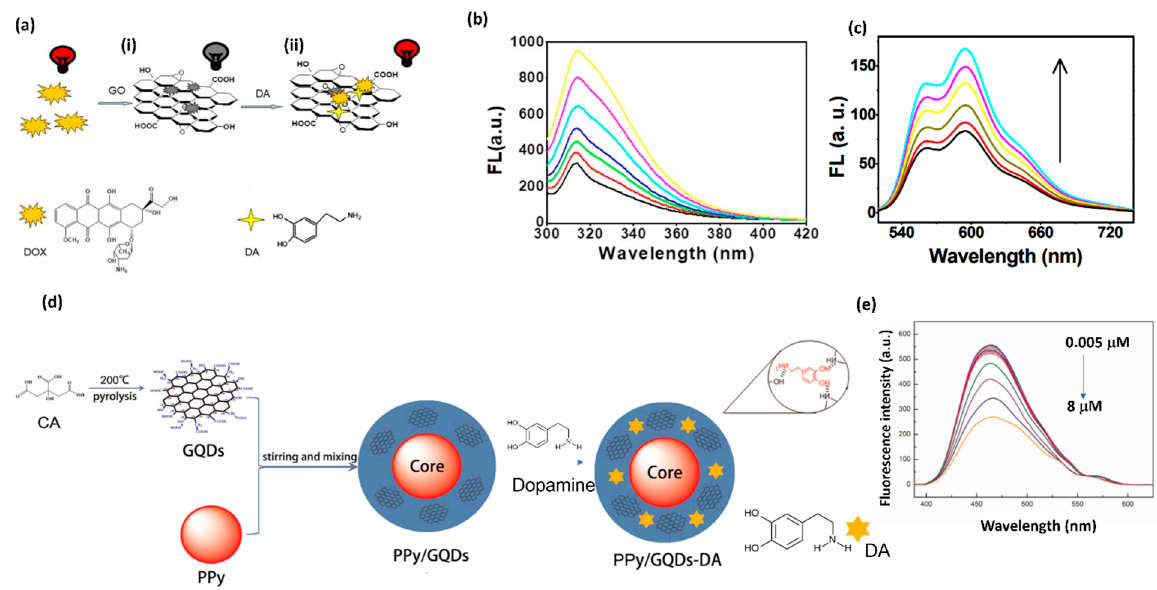
Figure 4. ( a ) Schematic illustration of DOX-GO complex and its fluorescence response along with the ( i ) turn off and ( ii ) turn on mechanism towards DA detection. ( b ) Fluorescence spectra of DOX-GO-DA solutions with the addition of DA concentrations ranging from 1.5 μ M to 6.0 μ M with excitation at 280 nm. ( c ) Fluorescence emission spectra of the DOX-GO for DA detection in human serum at fluorescence intensity of 598 nm. ( d ) Design of PPy/GQDs. ( e ) Fluorescence emission of spectra of PPy/GQDs with increasing concentrations of DA from 0.005 to 8 μ M.